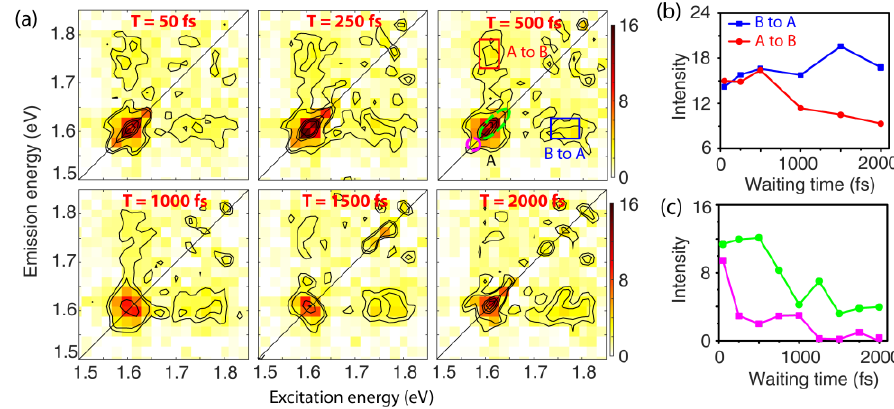
Fig. 2. (a) 2D absorptive spectra at different waiting times. In the map for T = 500fs, four regions of interest are marked with different colors. (b) Averaged intensity in the marked cross-peak areas as a function of waiting time (red: transfer from A to B, blue: transfer from B to A). (c) Averaged intensity in the two marked regions (green and purple) within peak A as a function of waiting